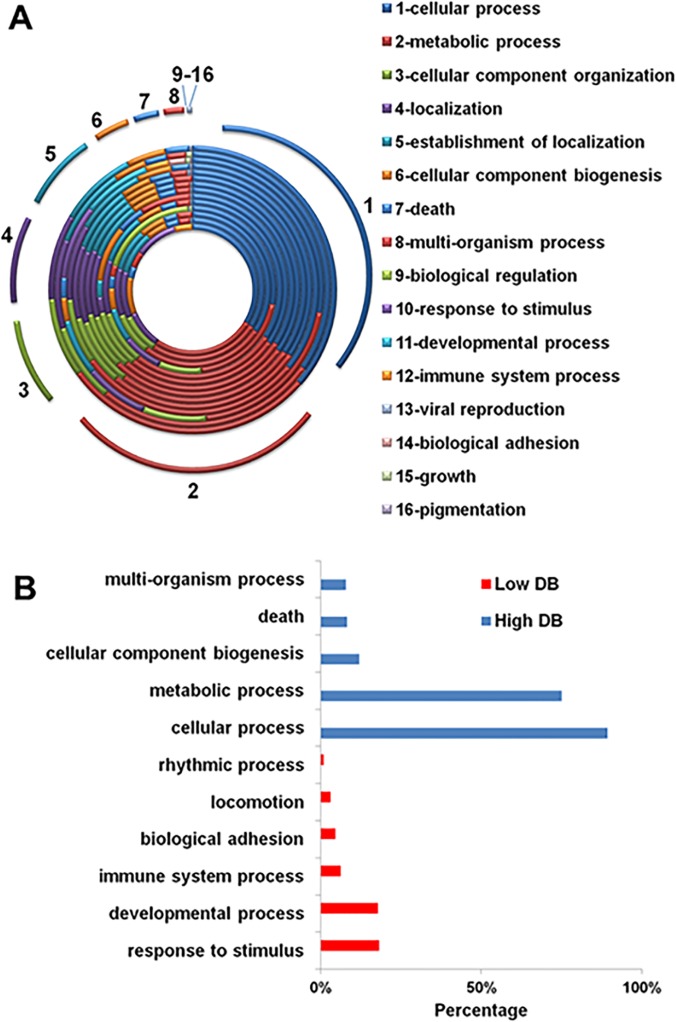
Gene ontology enrichment analysis of biological process of all the studies.From outer to inner circle, the displayed datasets are: “Fagerberg”, “Ramskold”, “Zhu_EST”, “Shyamsunder”, “Eisenberg_13”, “Reverter”, “Zhu_MA”, “Dezso”, “Chang”, “She”, “Tu”, “Podder”, “Warrington”, “Eisenberg_03”, and “Hsiao”.